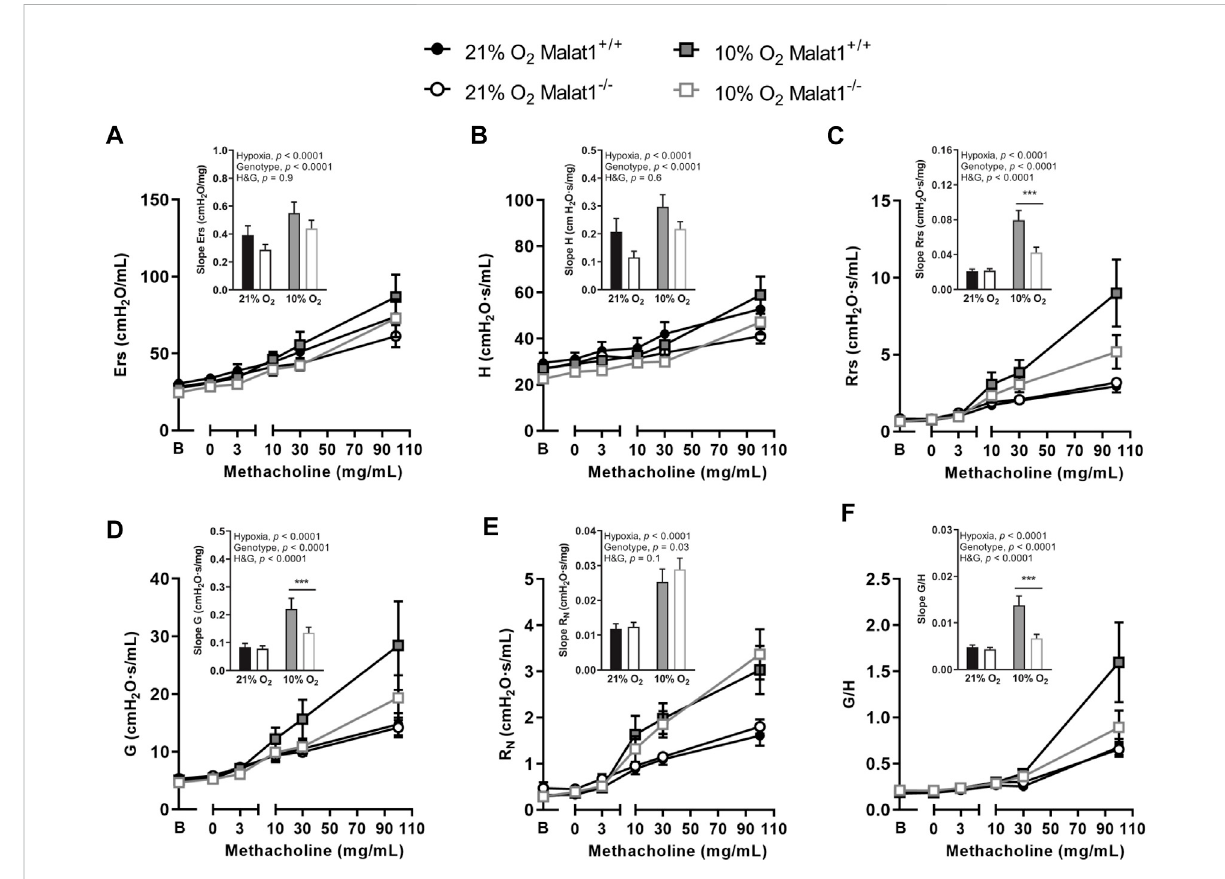
FIGURE 4 Responsiveness to methacholine In vivo respiratory mechanics in response to incremental concentrations of nebulized methacholine in Malat1 +/+ and Malat1 − / − male mice housed at either 21% O 2 or 10% O 2 for 8 days. The bar graph in the inset presents the slope of the methacholine concentration-responsecurveineachgroup. Thereadouts usedto assessthedegree ofresponsiveness tomethacholinewere: Ers,elastanceofthe respiratory system (A) ; H, lung tissue elastance (B) ; Rrs, resistance of the respiratory system (C) ; G, lung tissue resistance (D) ; R N , Newtonian resistancetoair fl owinthelargeconductingairways (E) ;and η ,hysteresivity (F) ,whichisG/H. n =8,8,11and10forMalat1 +/+ innormoxia,Malat1 − / − in normoxia, Malat1 +/+ in hypoxia and Malat1 − / − in hypoxia groups, respectively. Data were analyzed by two-way ANOVA and Tukey post-hoc tests. *** p <